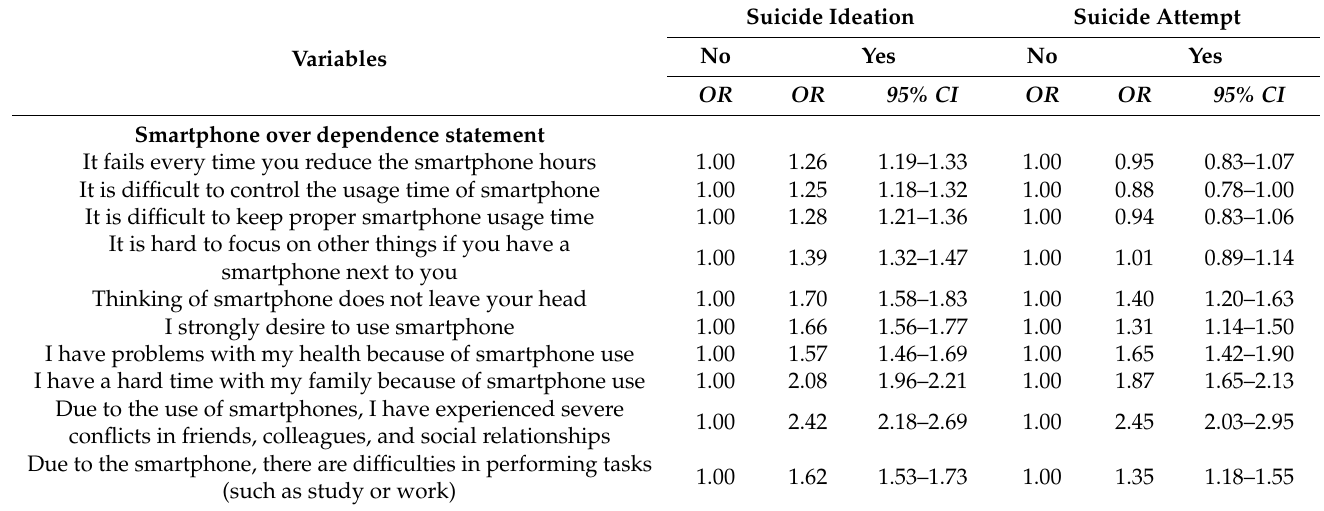
Table 5. Association between smartphone addiction and suicide ideation and attempt according to individual component of independent